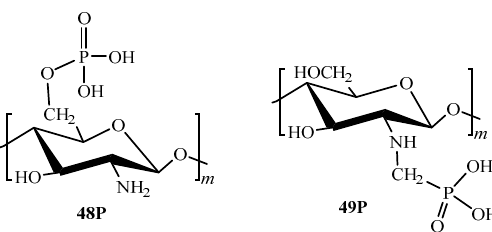
Figure 4. Structure of P-containing derivatives of chitosan without linkers: 48P —chitosan O-phosphate; 49P — N -methylenephosphonic acid chitosan.